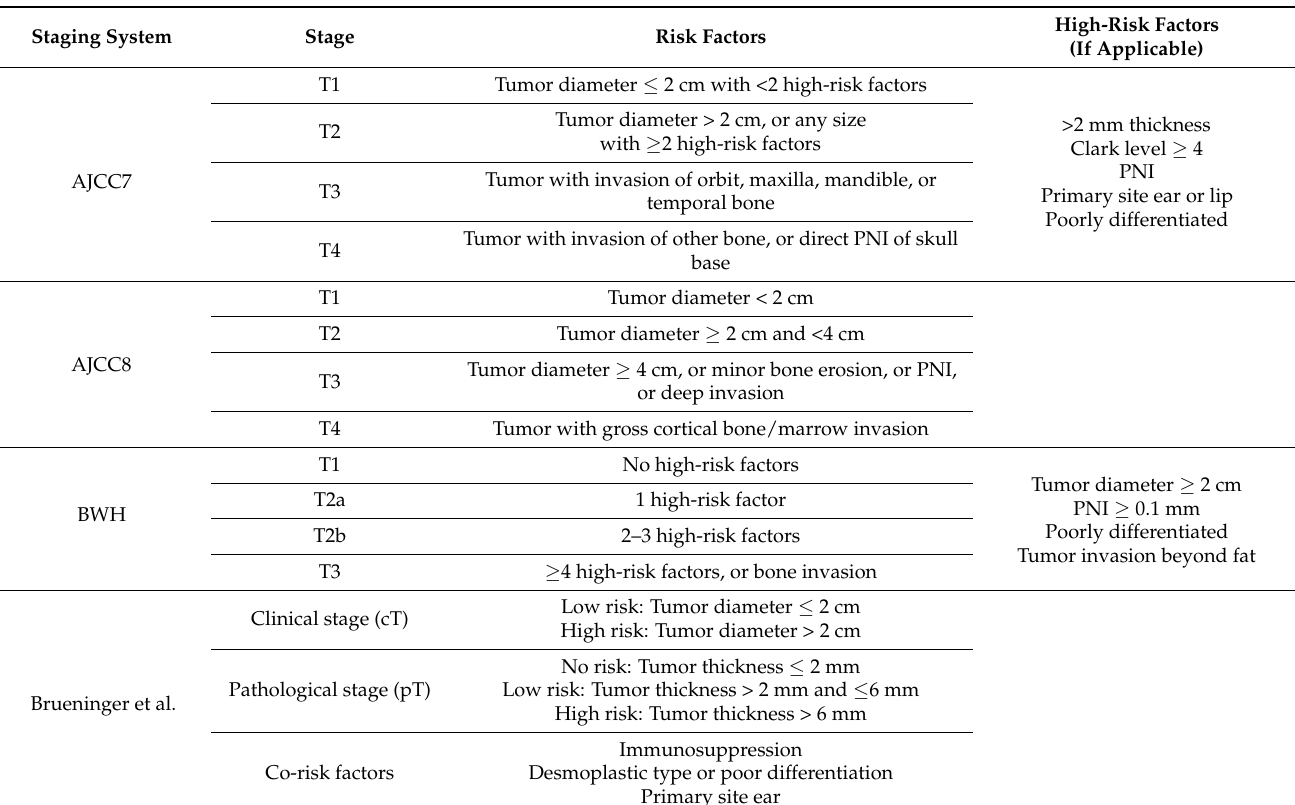
Table 2. Summary of four staging systems for cutaneous squamous cell carcinoma. PNI, perineu- ral